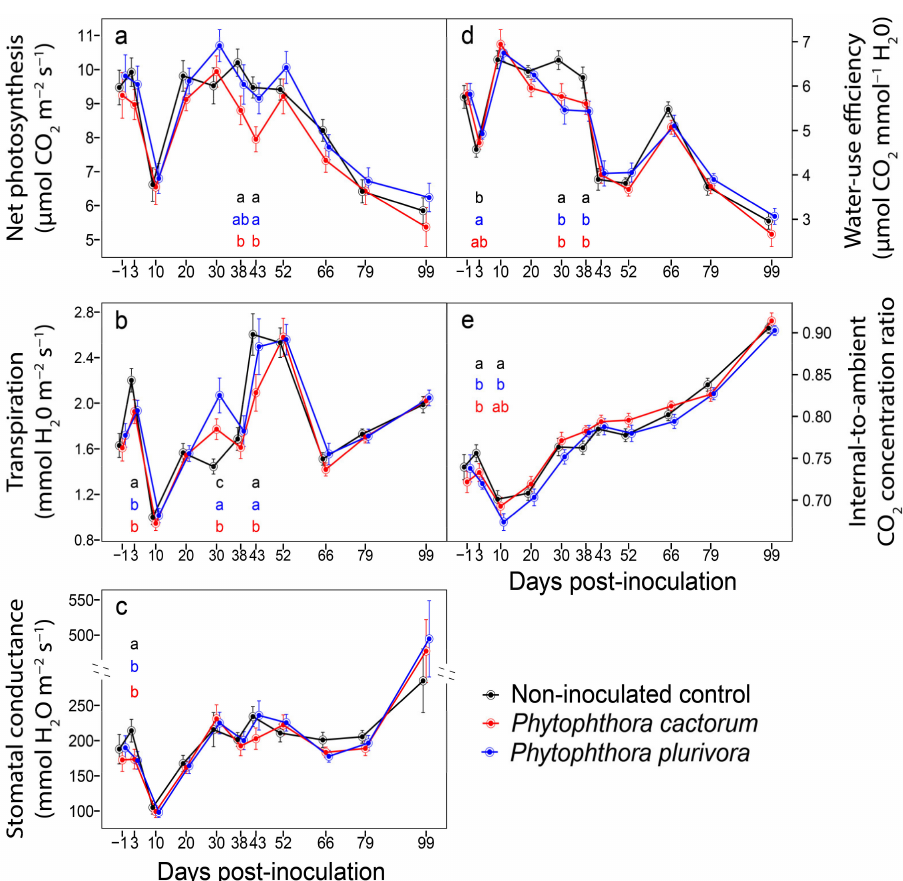
Figure 2. Gas exchange in hybrid poplar plants inoculated with Phytophthora cactorum , Phytophthora plurivora , and non- inoculated control plants. ( a ) Seasonal results of net CO 2 assimilation rate. ( b ) Seasonal results of transpiration rate. ( c ) Seasonal results of stomatal conductance. ( d ) Seasonal results of instantaneous water-use efficiency. ( e ) Seasonal results of internal-to-ambient CO 2 concentration ratio. Data represent means ± SE. Different letters indicate significant differences among the examined Phytophthora treatments ( p ≤ 0.05). No letters indicate that there were no significant differences among the treatments ( p >